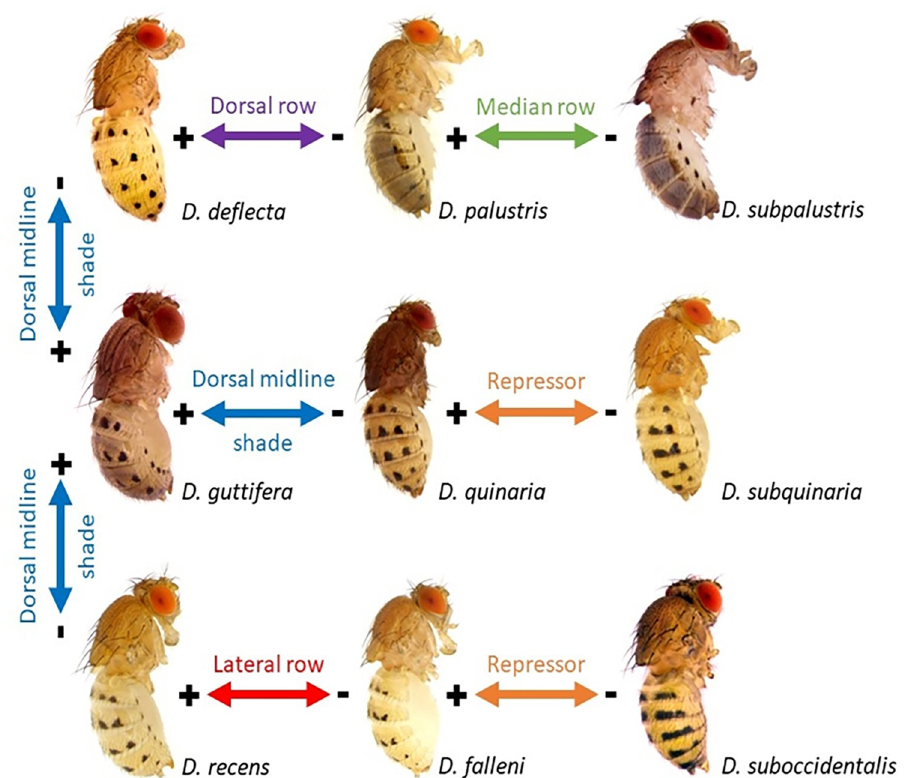
Fig 3. Deviations from the D . guttifera ground plan led to the abdominal color pattern diversity in the quinaria species group. + = gain, - = loss of a pattern element. “Repressor” suggests that stripes may be broken into spots by unidentified repressors of pigmentation. The arrows solely illustrate the modularity of these complex patterns and do not imply any evolutionary direction.